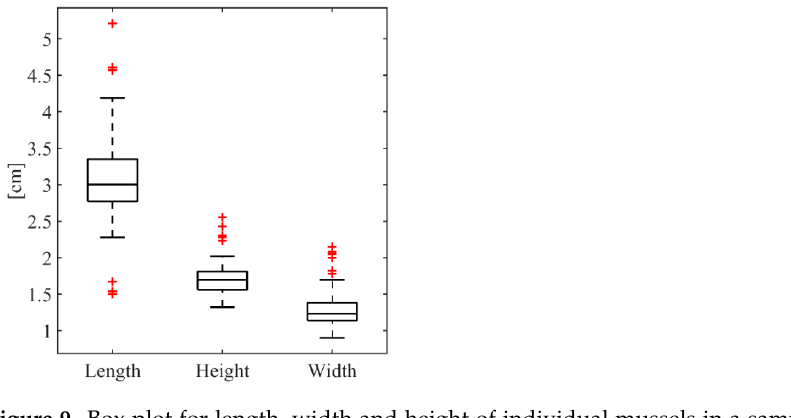
Figure 9. Box plot for length, width and height of individual mussels in a sample of 82 mussels; outliers are marked as red crosses.